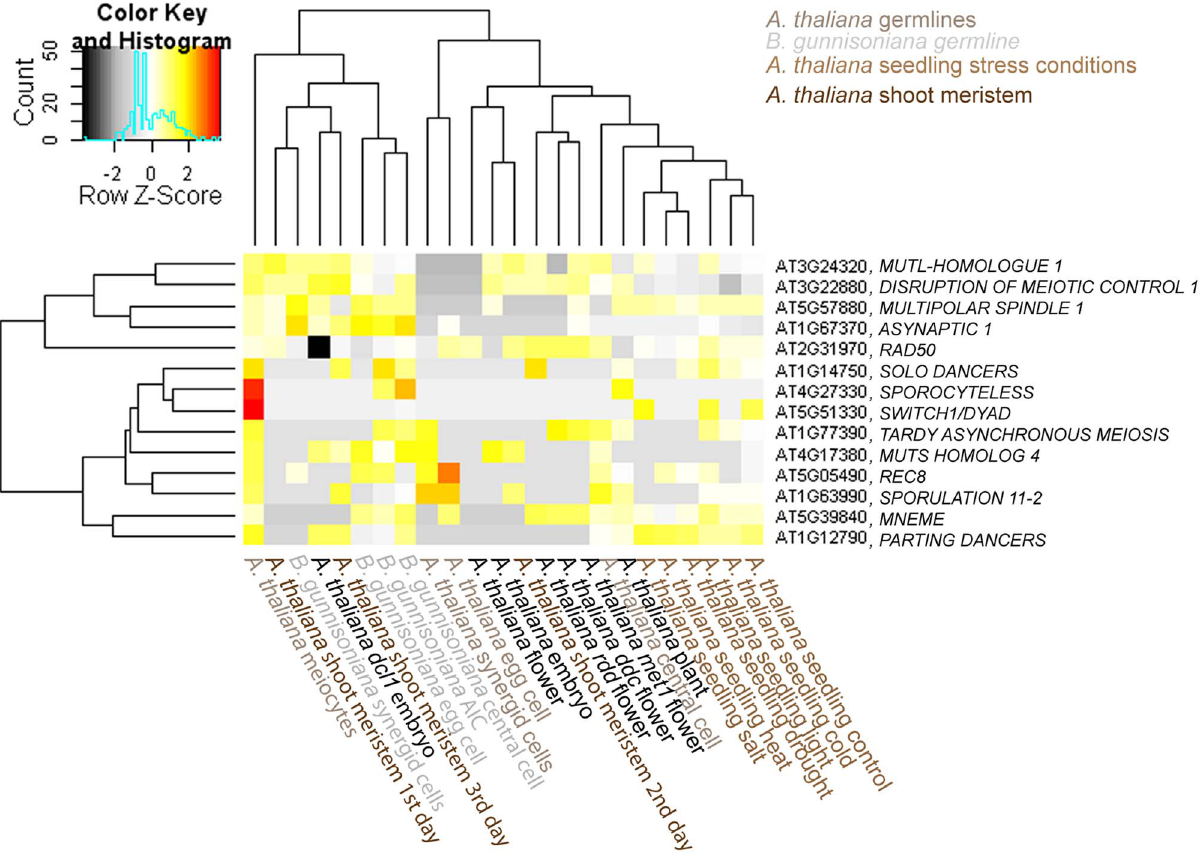
Figure 5. Heatmap of log2 transformed normalized read counts for 14 selected meiotic or MMC-expressed genes. Hierachical clustering of read counts from different Arabidopsis and Boechera cell- and tissue types [13,62–66]. The hierarchical clustering of samples and genes was based on euclidean distance and hierarchical agglomerative clustering. Colours are scaled per row. Red denotes high expression and black low expression.